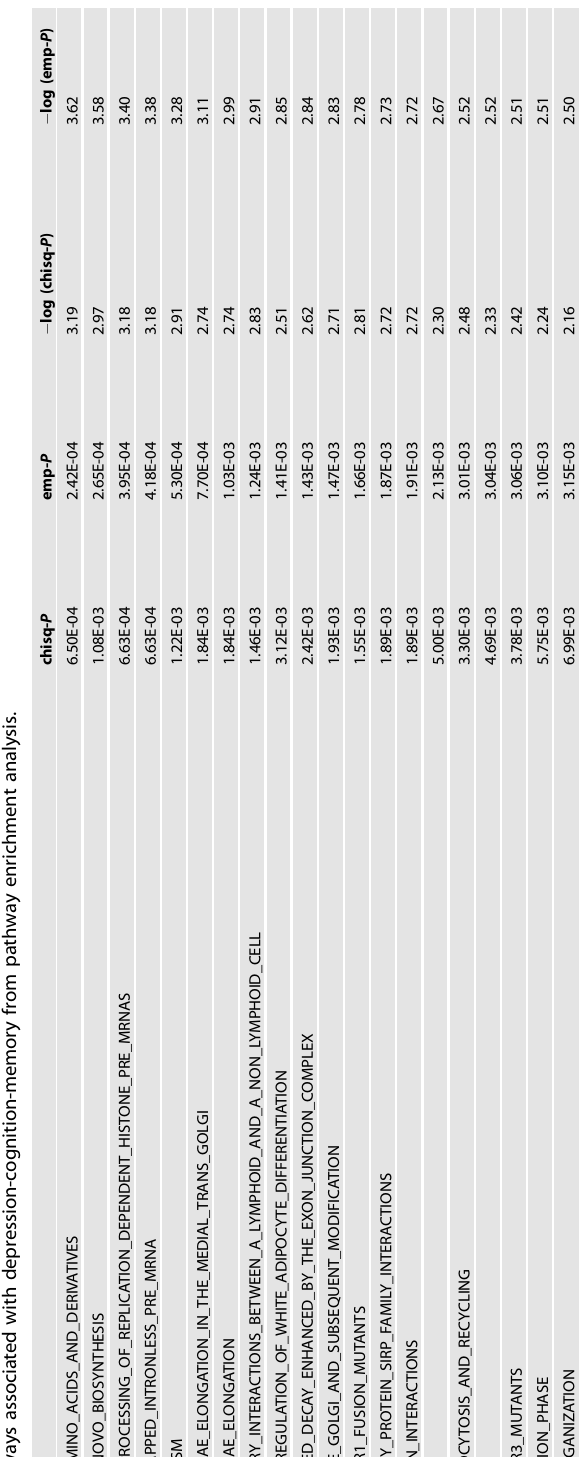
[57]. (7) Other semaphorin interactions pathway containing four types of plexins and eight classes of semaphorins is involved in plexin-A4 can mediate A β -induced tau pathology in the patho- genesis of AD [90]. However, some pathways, such as cortisol/ stress responses and cholinergic and serotonergic function [10], have been clearly linked to both depression and AD but were not identi fi ed as top pathways in the current study with higher P values (stress pathway: emp- P = 2.60 × 10 − 2 ,